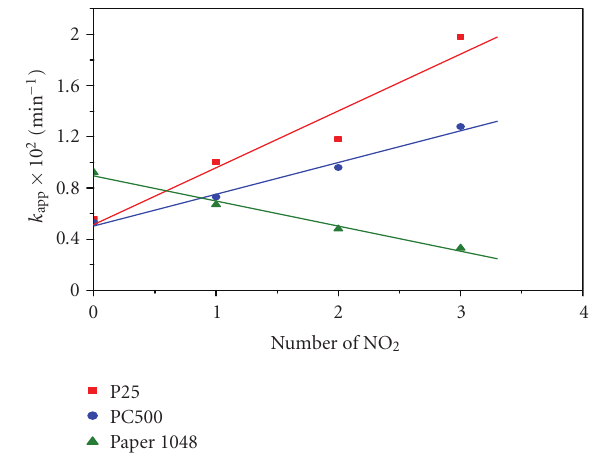
Figure 5: Linear variations of the rate constants with the number of NO 2